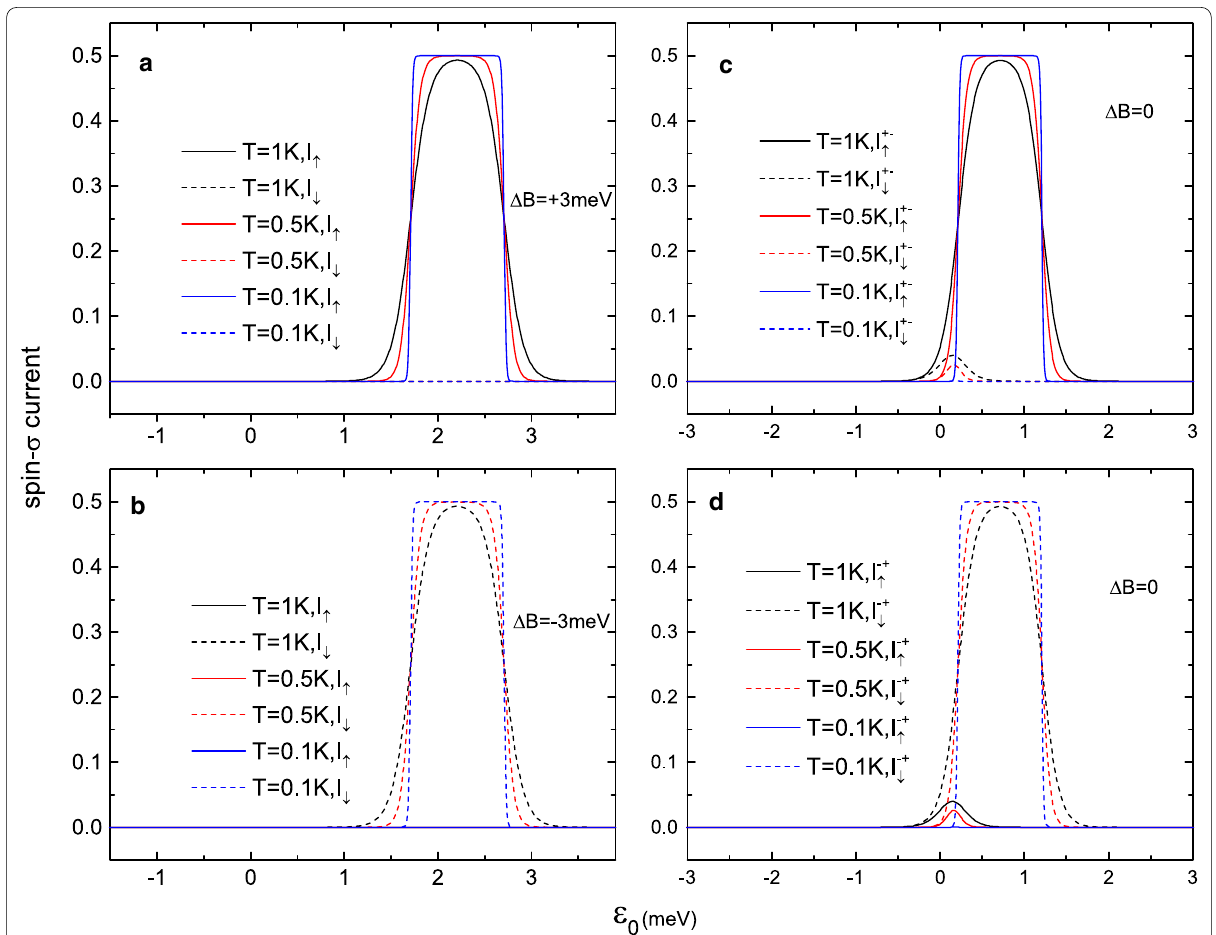
Fig. 5 Spin- σ currents I ↑ ( ↓ ) a , b in the presence of an external magnetic field of a B = + 2 meV or b B = − 2 meV and c , d in the absence of a magnetic field as functions of the molecular level ε